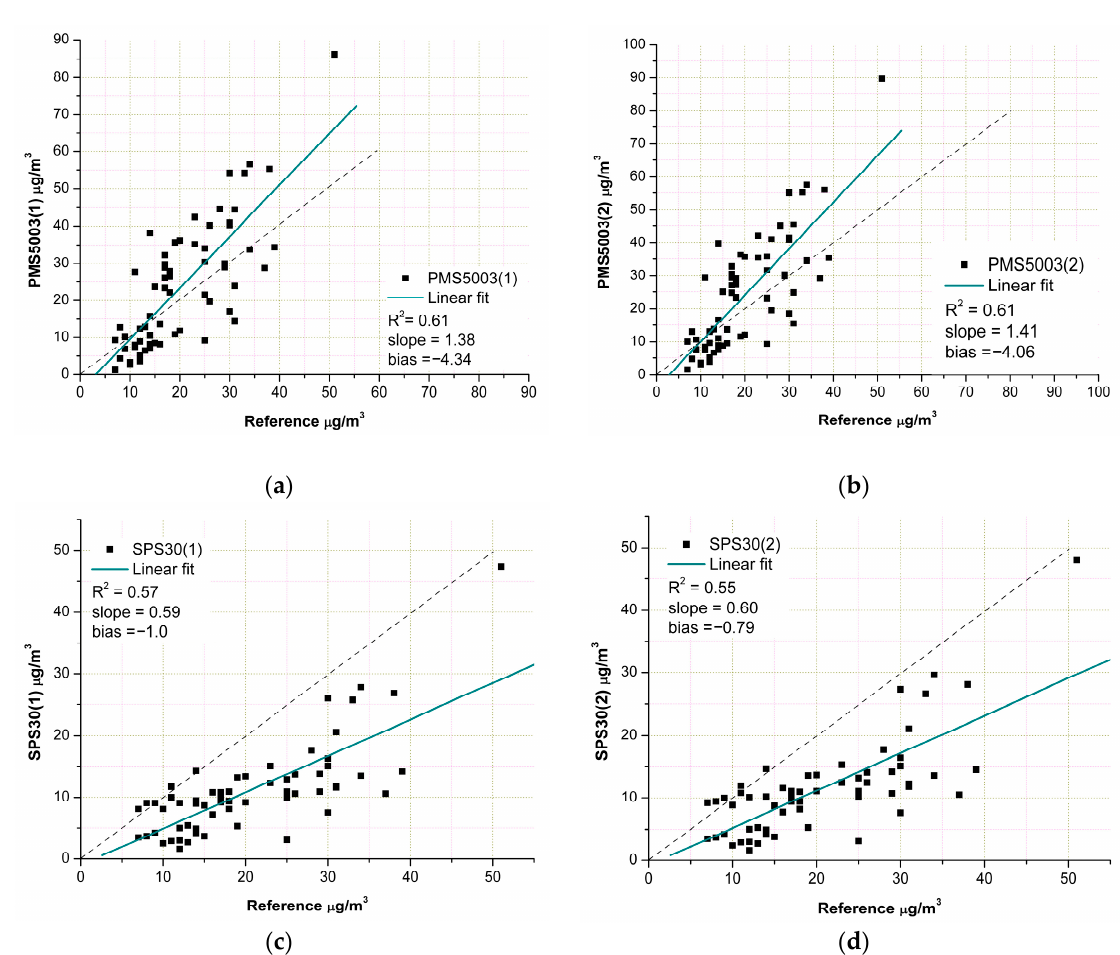
Figure 6. ( a ) PMS5003(1); ( b ) PMS5003(2); ( c ) SPS30(1); ( d ) SPS30(2). Comparison between the four copies of the PM sensors involved in this research and the reference device. The solid line represents a linear regression fit computed through the ordinary least squares method, while the dashed line indicates the 1:1 reference line. In the corners of the figures, the statistics are reported. The slope and bias are related to the slope and the intercept of the linear fit.